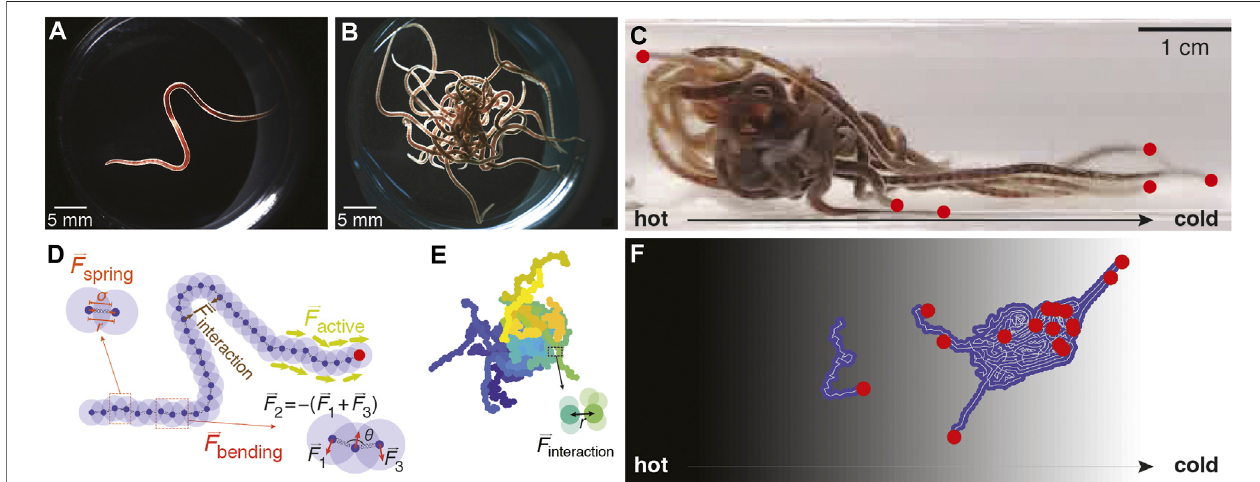
active generatingself-propulsion. σ and repulsiveifthey